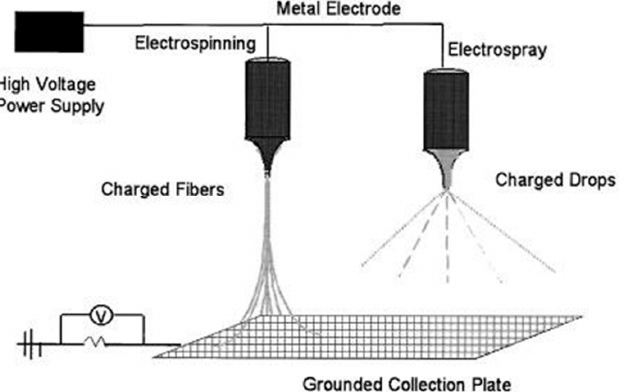
Figure 5. Schematic representation of electrospinning and electrospray; reproduced with permis ‐ sion from [82].